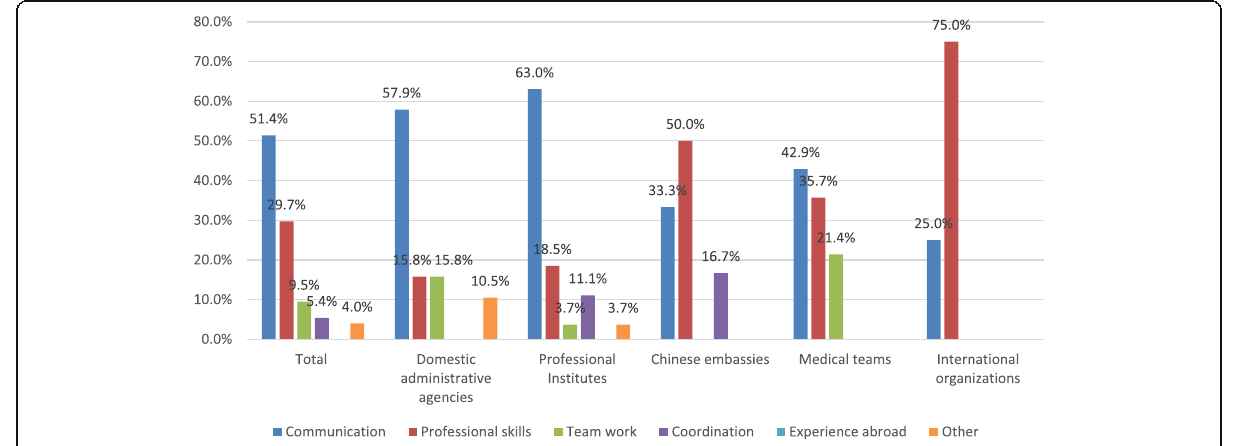
Fig. 1 Core competencies required for Chinese global health workforce according to five different organizations